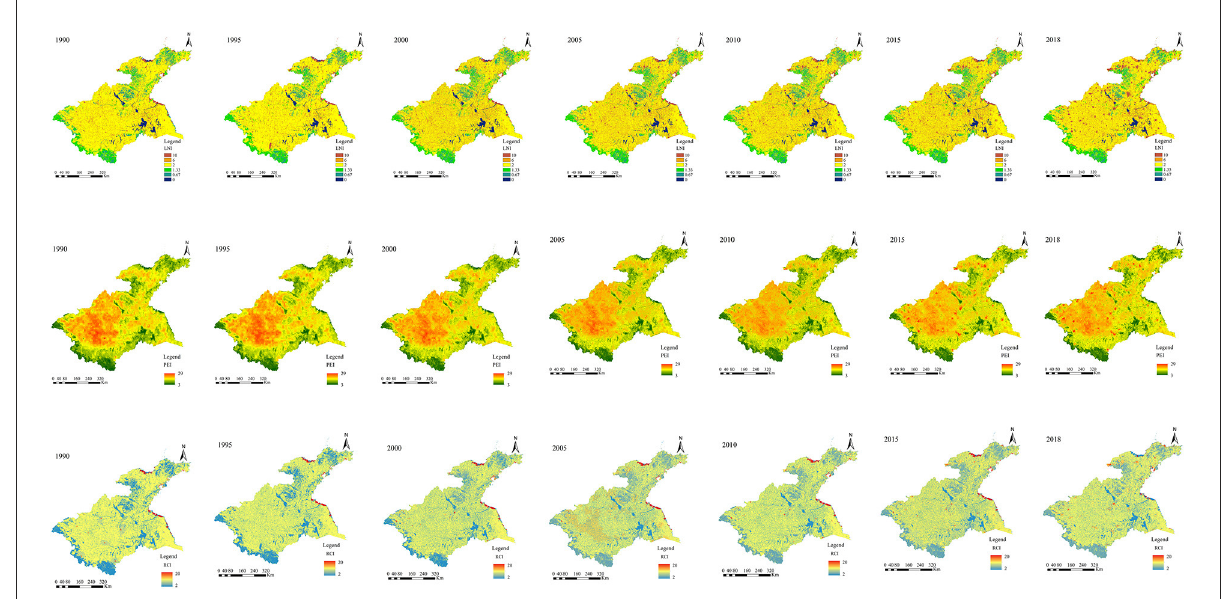
FIGURE4 Spatiotemporal distribution of LNI, RCI, and PEI in the Huaihe River Basin over the 1990–2018